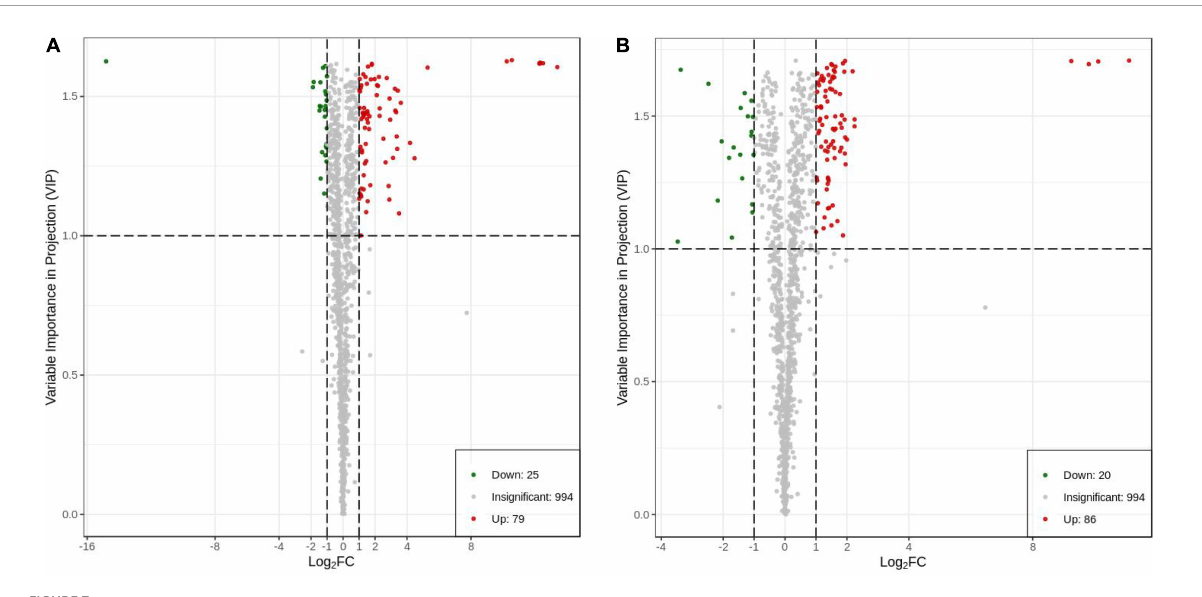
FIGURE7 Differential metabolite volcano plot. Each point in the volcano plot represents a metabolite, in which the green point represents the down-regulated differential metabolite, the red point represents the up-regulated differential metabolite, and the gray represents the metabolite detected but not significantly different; the abscissa represents a metabolite In the logarithm of the relative content difference between the two groups of samples (log2FC), the larger the absolute value of the abscissa, the greater the relative content difference of the substance between the two groups of samples. The ordinate represents the VIP value, and the larger the ordinate value, the more significant the difference. (A) HN44 group; (B) HN65 group.